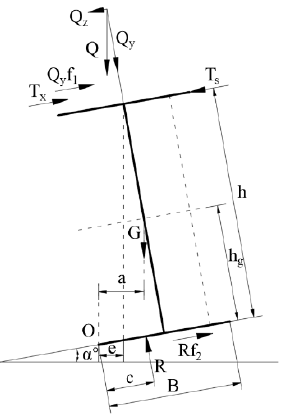
Figure 4. Static scheme of the support